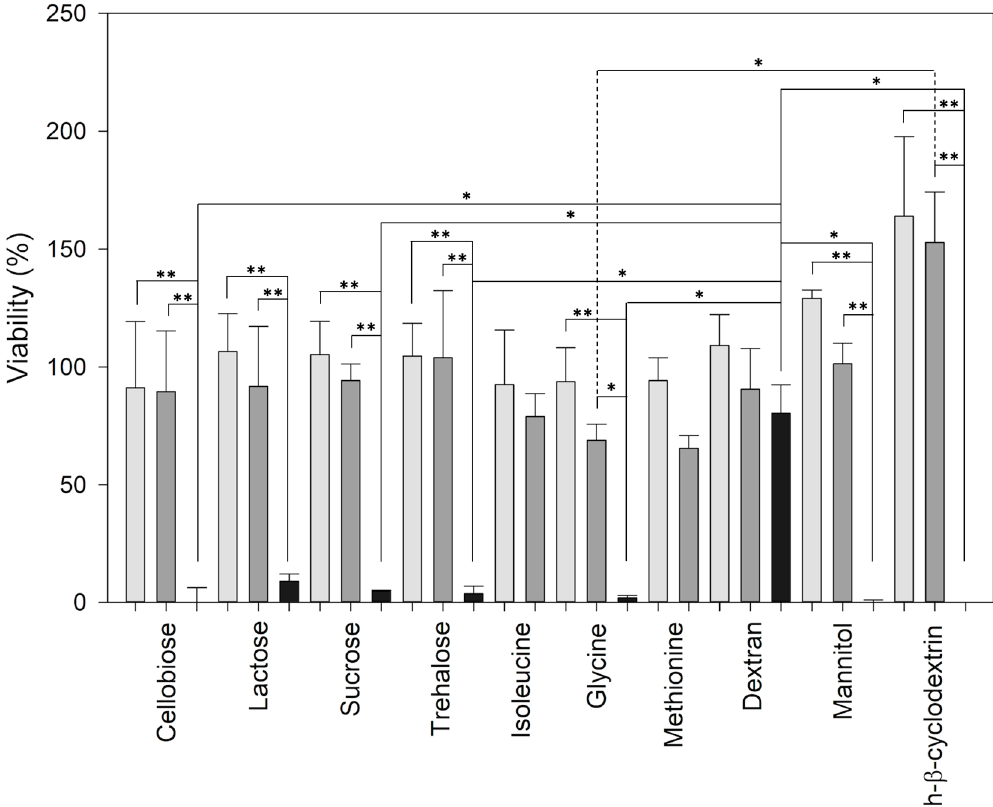
Figure 2. The graph represents the viability of lymphocytes after 24 h of treatment with the different excipients. Light grey is 1 mg/mL, dark grey is 10 mg/mL, and black is 100 mg/mL. Data are displayed as mean ± SE. ** for p ≤ 0.001 and * for p ≤ 0.05. Black asterisks represent the comparison of excipients at the three concentrations, without isoleucine and methionine.